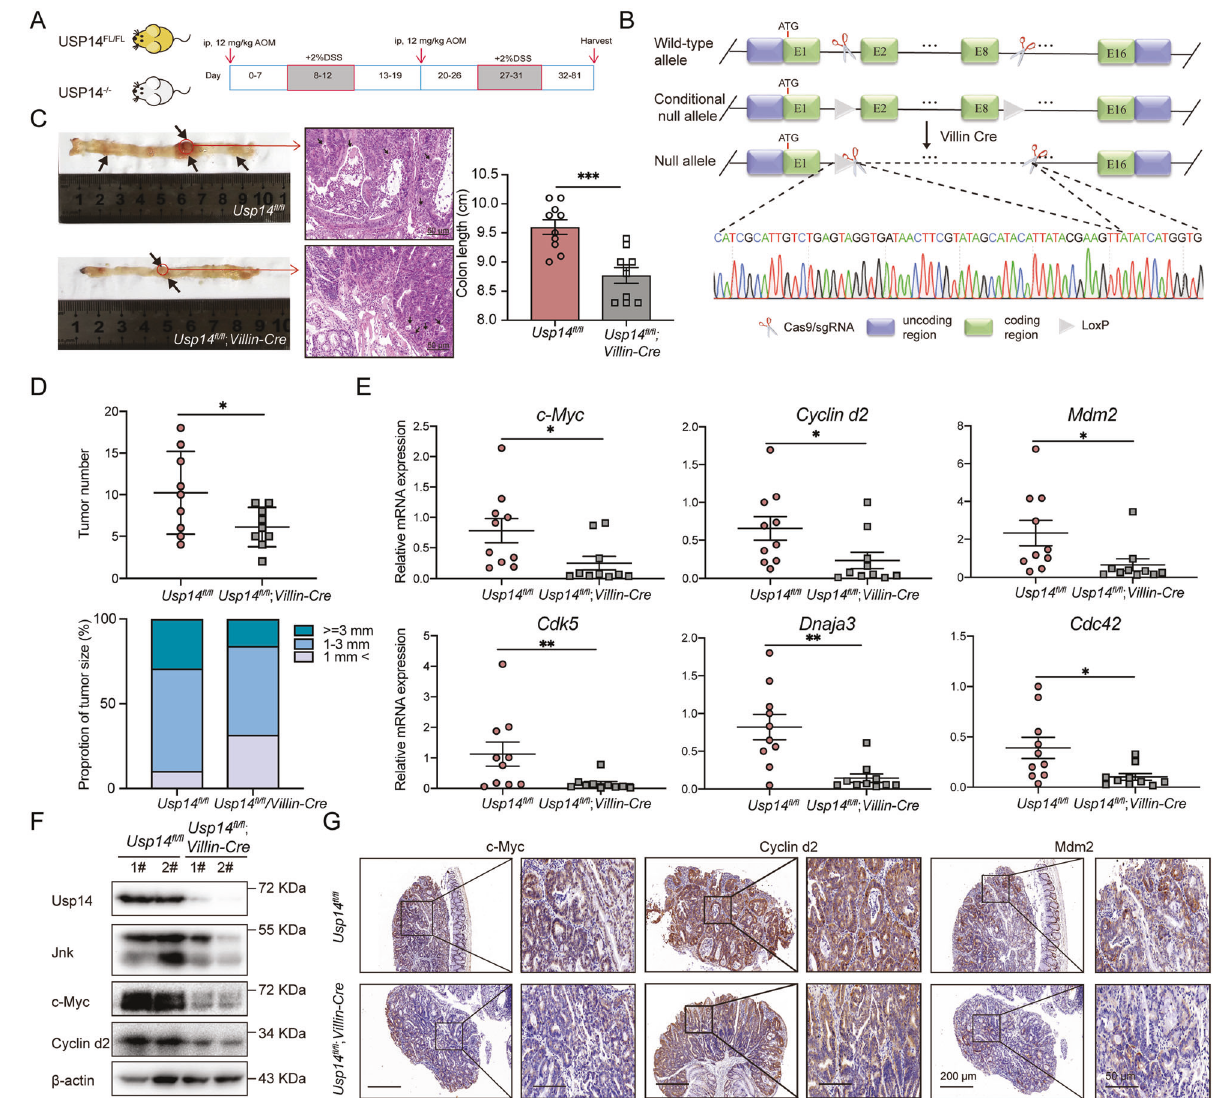
Fig. 6 Genetic depletion of USP14 alleviates tumorigenesis in vivo. A A schematic of the AOM/DSS-induced colorectal cancer model. B The USP14 genomic sequence after CRISPR/Cas9 edit. C H&E staining and colon length between the wild-type and USP14-de fi cient colorectal cancer model mice. The black arrows show location of the tumors. D The number and size of tumors in the wild-type and USP14-de fi cient colorectal cancer model mice. E The mRNA levels of the indicated JNK target genes in the wild-type and USP14-de fi cient colorectal cancer model mice ( n = 10). F The protein levels of the indicated JNK target genes in the wild-type and USP14-de fi cient colorectal cancer model mice. G Image of IHC staining for c-Myc, Cyclin d2, and Mdm2 in the tissues of wild-type and USP14-de fi cient colorectal cancer model mice. The data are presented as the means ± SEM. Statistical signi fi cance was analyzed by Student ’ s t test. * p < 0.05, ** p < 0.01, *** p < 0.001, *** p <